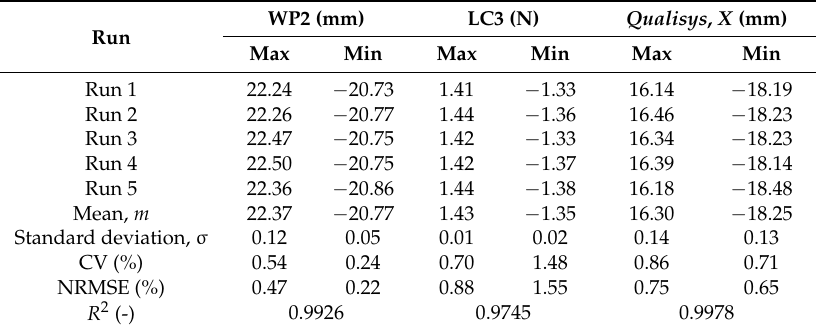
Table 9. Results of repeatability analysis for wave with wind